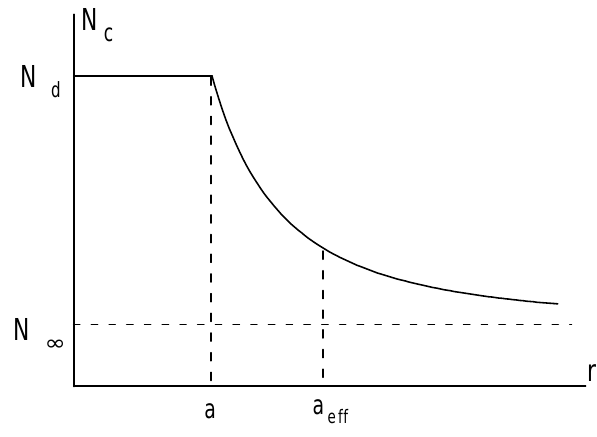
Fig. 1. Model plasma density distribution across the